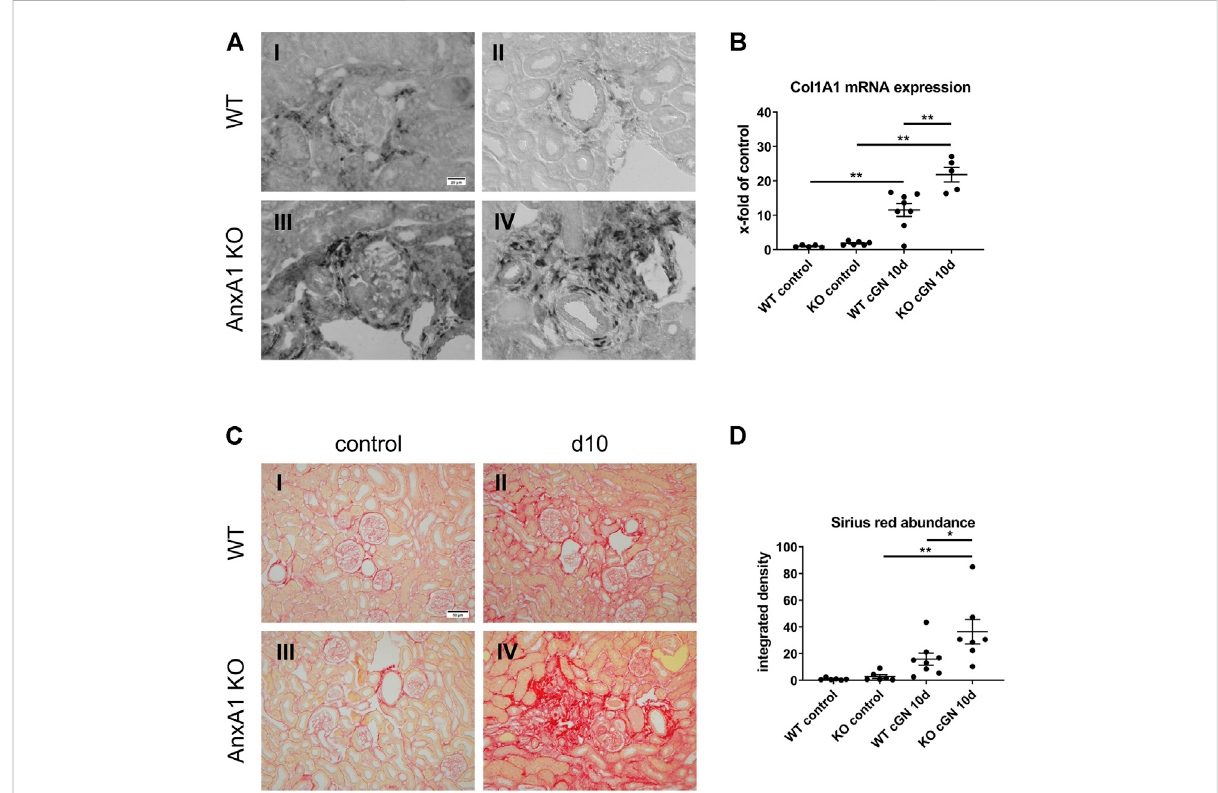
FIGURE 7 De fi ciency of annexin A1 aggravates renal fi brosis. (A) Representative images of alpha-1 type 1 collagen (Col1A1) mRNA in situ hybridization performed on kidney sectionsfrom wildtype (WT; I,II) and annexin A1(AnxA1)-de fi cient mice (KO; III,IV) atd10 after injection of normal sheep serum (control)orinductionofcrescenticglomerulonephritis(cGN).Col1A1mRNAsignalislocalizedto fi broblastsintheperiglomerularregionofdamaged glomeruli(I,III) andtheperivascularspaceofarcuatearteries(II,IV). (B) TaqMan ® realtimeRT-PCRquanti fi cationofCol1A1mRNAabundancein WT and KO mice at d10 after cGN induction. (C) Representative images of Sirius Red-stained kidney sections from WT (I,II) and KO (III,IV) mice at d10after cGNinduction incontrol- (I, III),orcGNmice (II,IV). (D) Quanti fi cation ofrenal cortical SiriusRed signal byautomated imageanalysis shows an increased abundance in the KO cGN mice as compared to the nephritic WT mice. Scale bar = 20 μ m in A and 50 µm in (C) . Dots in B and D represent values from individual mice; horizontal lines indicate meanvaluesanderror bars represent theSEM.Statistical signi fi cance ofchanges